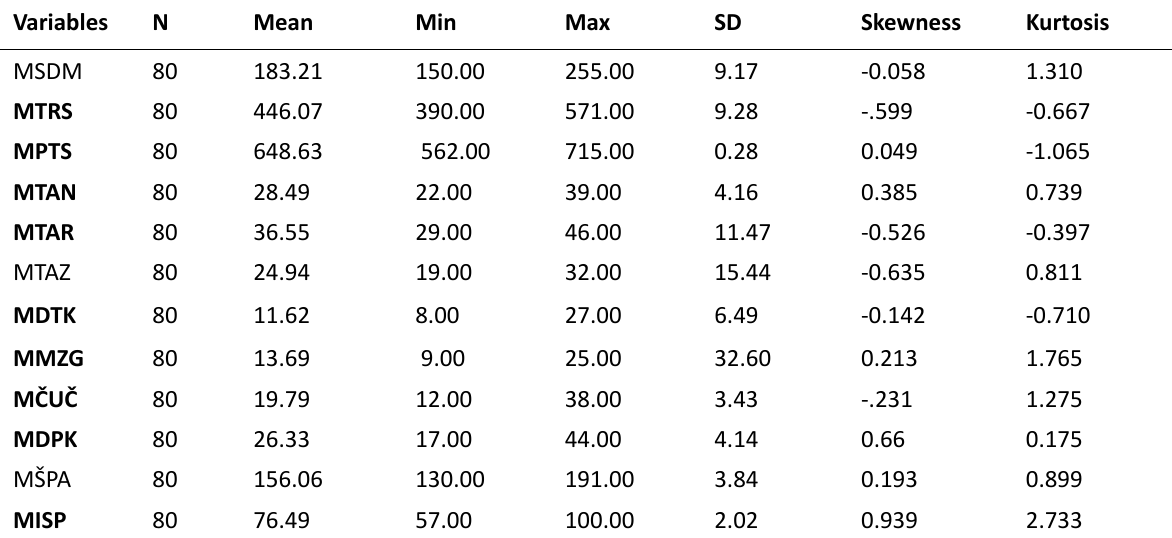
Table 1. Basic statistical parameters for the assessment of motor skills Variables